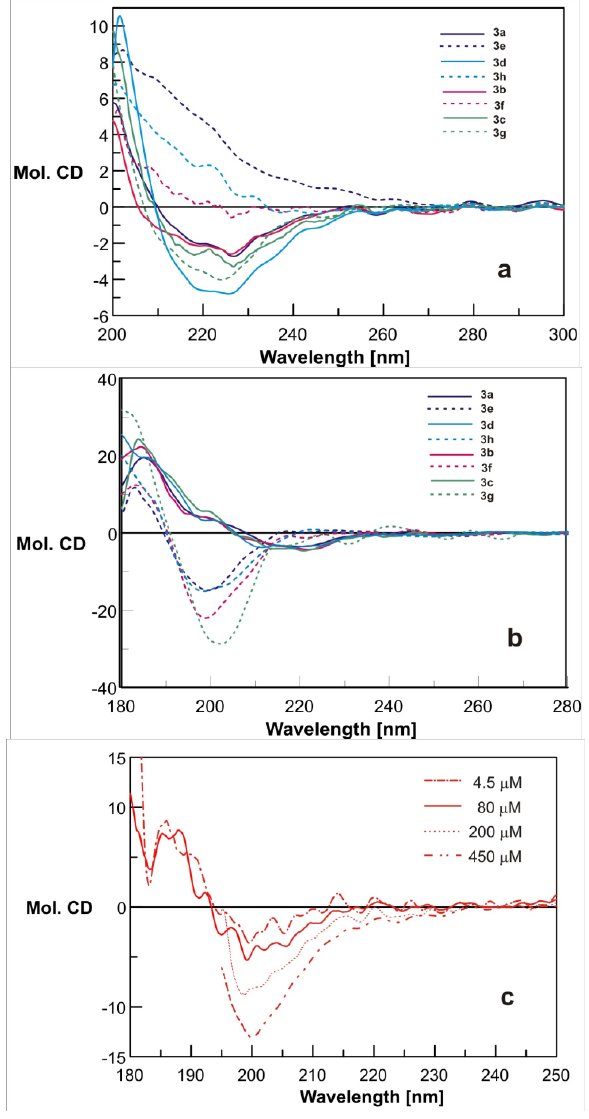
Figure 5. Molar ellipticity of dendrimers 3a – h : ( a ) in MeOH, and ( b ) in water at peptide concentration ca 80 µM; ( c ) molar ellipticity of 3f measured in 10 mmol PBS at various dendrimer